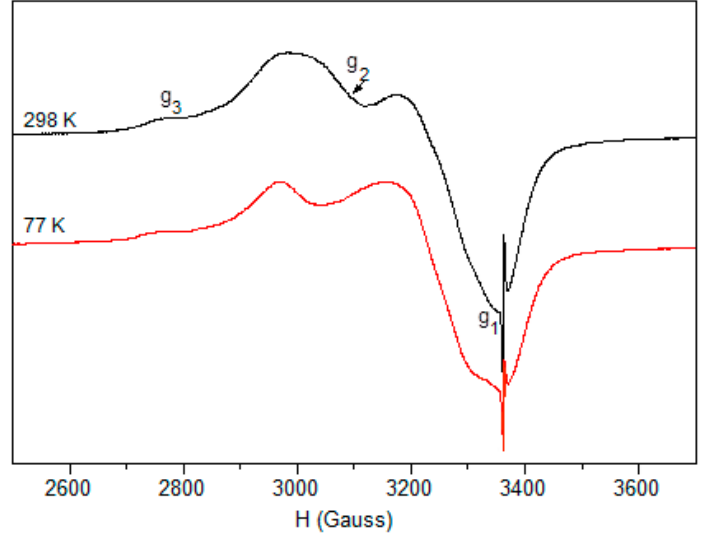
Figure 3. EPR spectrum of complex 5 in the state at 298 K and 77 K.